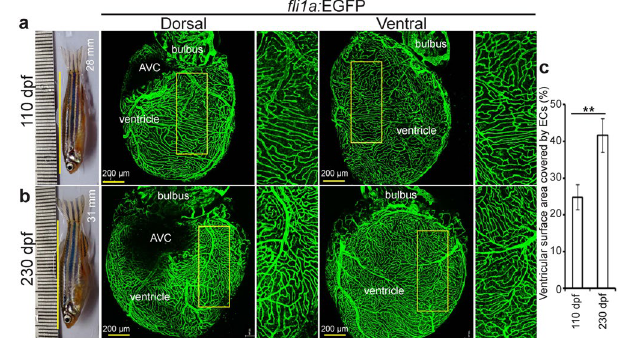
Figure 1. Zebrafish coronary vessels continue to grow after 3 months post fertilization. ( a,b ) Representative brightfield images of adult zebrafish and maximum intensity projections of confocal images of freshly isolated hearts from 110 ( a ) and 230 ( b ) dpf Tg(fli1a:EGFP) animals. Green cells have pan-endothelial identity. ( c ) Quantification of cardiac ventricular surface area covered by endothelial cells (n = 3 of each stage, mean ± SEM). One way ANOVA followed by Bonferroni’s post-hoc test (GraphPad Prism) was performed to evaluate statistical significance of differences. P < 0.05 was considered statistically significant. ** corresponds to